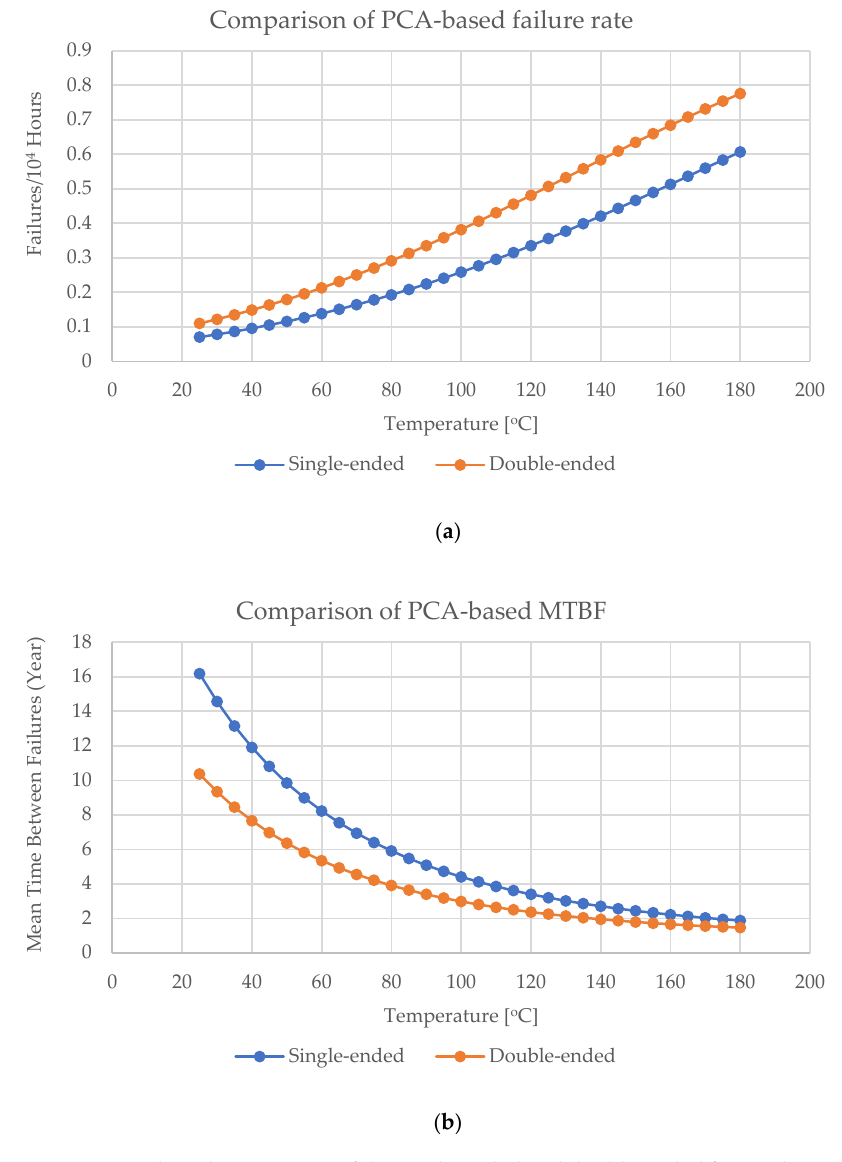
Figure 5. PCA-based comparison of the single-ended and double-ended forward converter: ( a ) failure rate; ( b ) mean time between failures (MTBF).